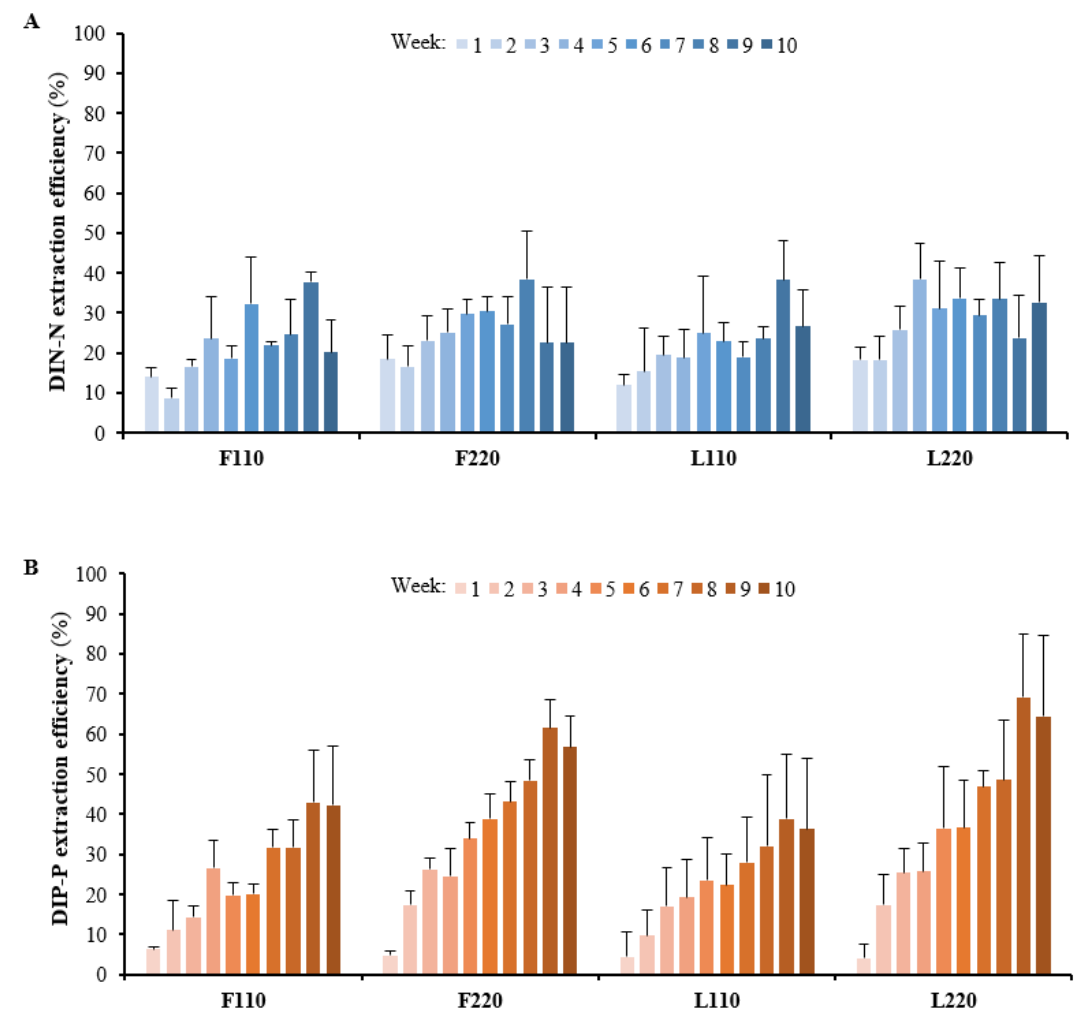
Figure 3. Extraction efficiency of ( A ) DIN – N and ( B ) DIP – P ( n = 5). Error bars represent standard deviations.